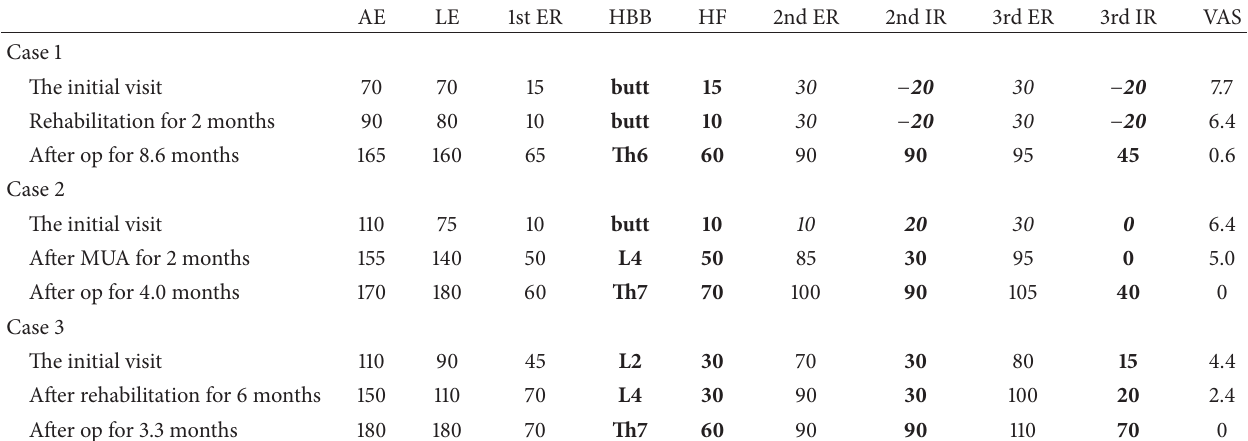
Table 1: Range of motion and visual analogue scale of Cases 1, 2, and